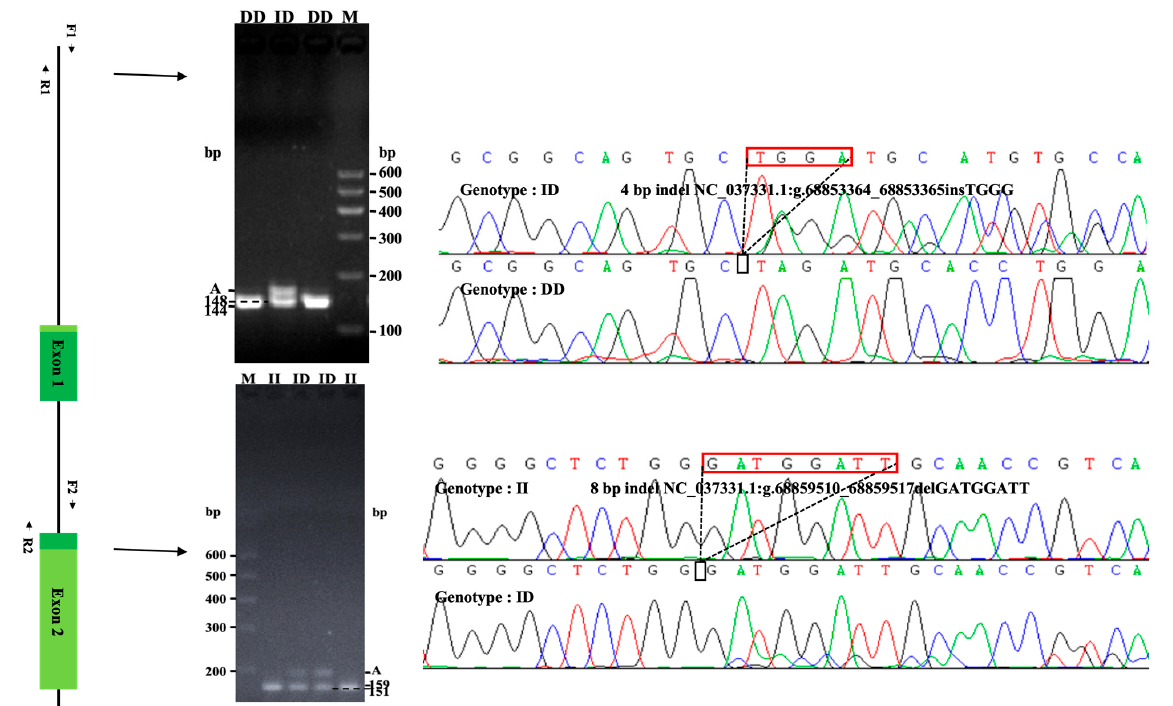
Figure 6. Agarose electrophoresis and sequencing chromas of InDels in the cattle HOXA11 gene. Agarose electrophoresis and sequencing chromas for cattle HOXA11 P1-Ins-4-bp InDel. Agarose electrophoresis and sequencing chromas for cattle HOXA11 P2-Del-8-bp InDel. Sequencing chromas showed homozygous insertion type (II), heterozygous genotype (ID) and homozygous deletion type (DD). The A represents the non-target fragment, which is heteroduplex.